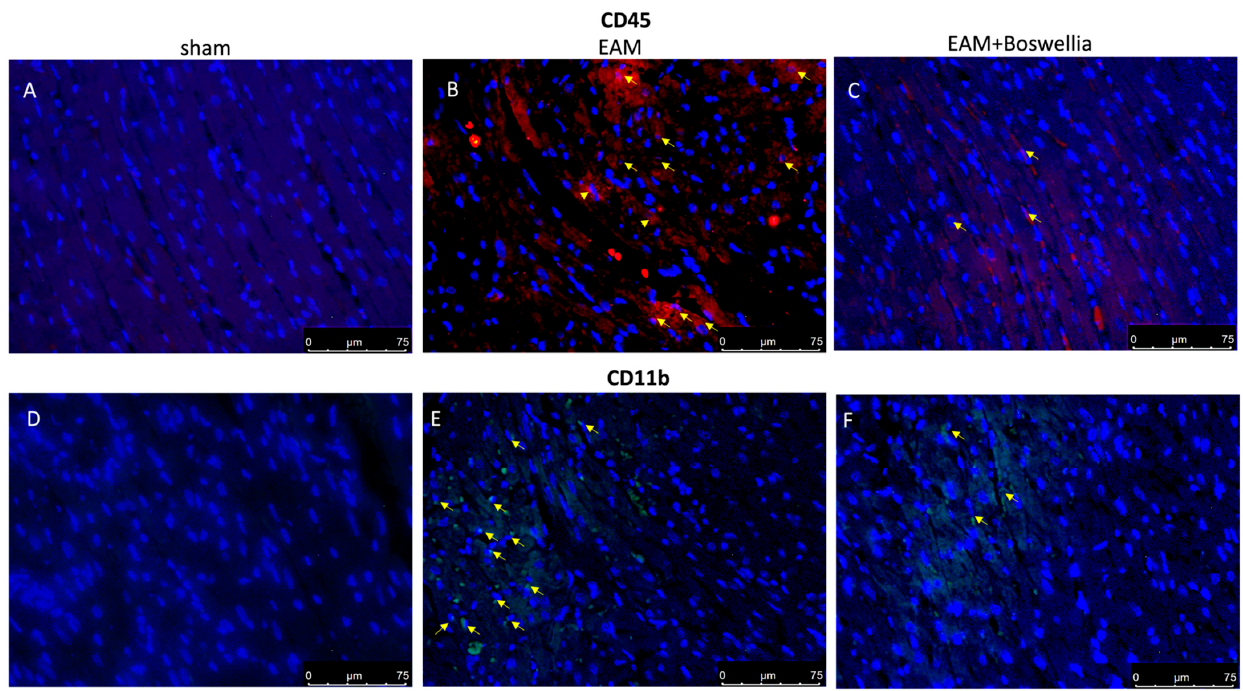
Figure 7. Effect of Boswellia extract on CD45 and CD11 β expressions. Immunofluorescence for CD45 “red” and CD11 β “green” (see yellow arrows) in heart sections of sham ( A , D ), EAM + vehicle ( B , E ) and EAM + Boswellia gum extract ( C , F ). Boswellia extract administration was able to reduce CD45 and CD11 β expressions. Scale bar: 75 µ m. Magnification (40 ×